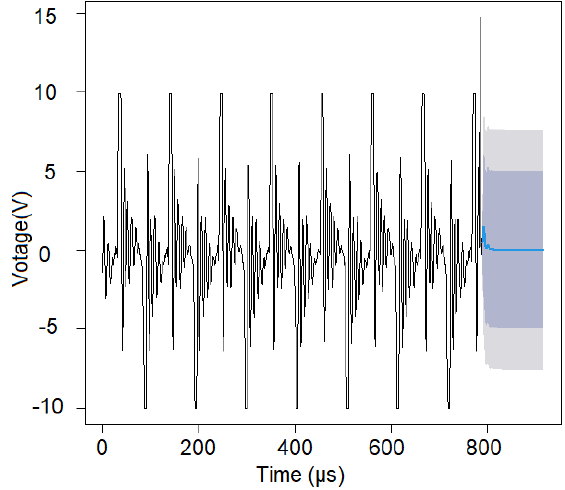
Figure 6. The signal (black) and forecast (blue) and the 0.95 and 0.99 confidence levels (at the right-hand side in different nuances of grey) (obtained using the R software).